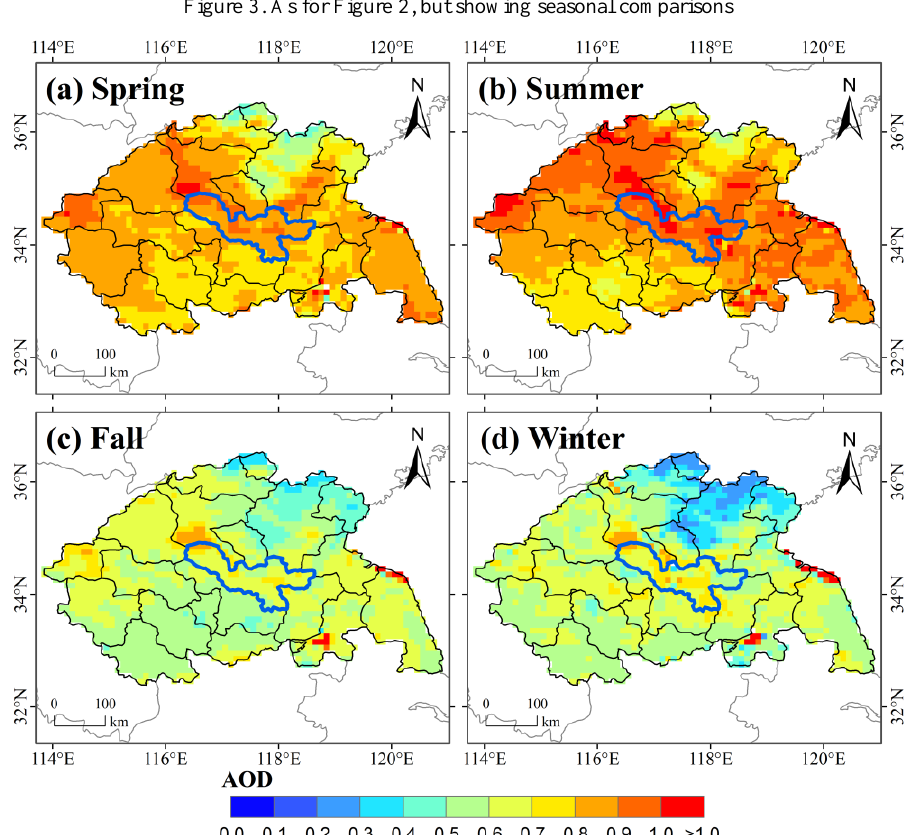
Figure 4. 2000-2018 seasonal average of 10 km MODIS AOD over